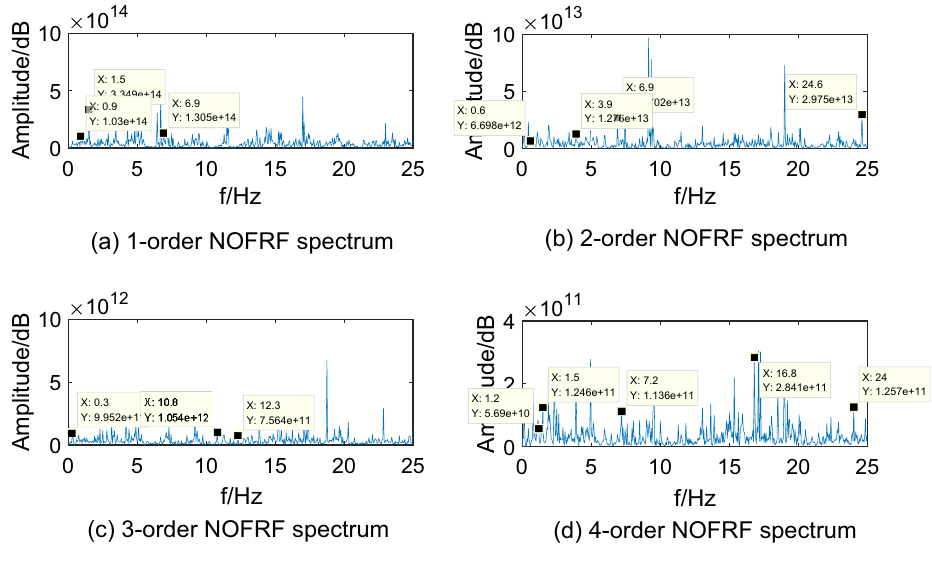
Figure 6. NOFRF spectrum of first 4-order in R1.